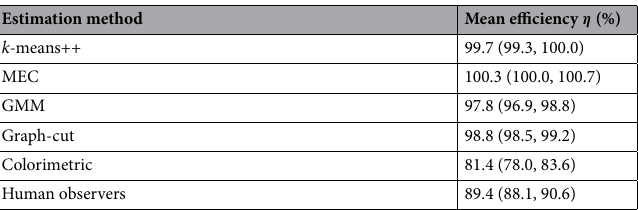
Table 1. Efficiencies of methods for estimating information from relevant colors relative to minCEntropy clustering. Mean efficiencies η are given for three clustering methods, the colorimetric method, and six human observers. Values of η were averaged over 20 images and numbers of relevant colors n . Estimated 95% BCa confidence limits 36 are shown in parentheses, based on 1000 bootstrap